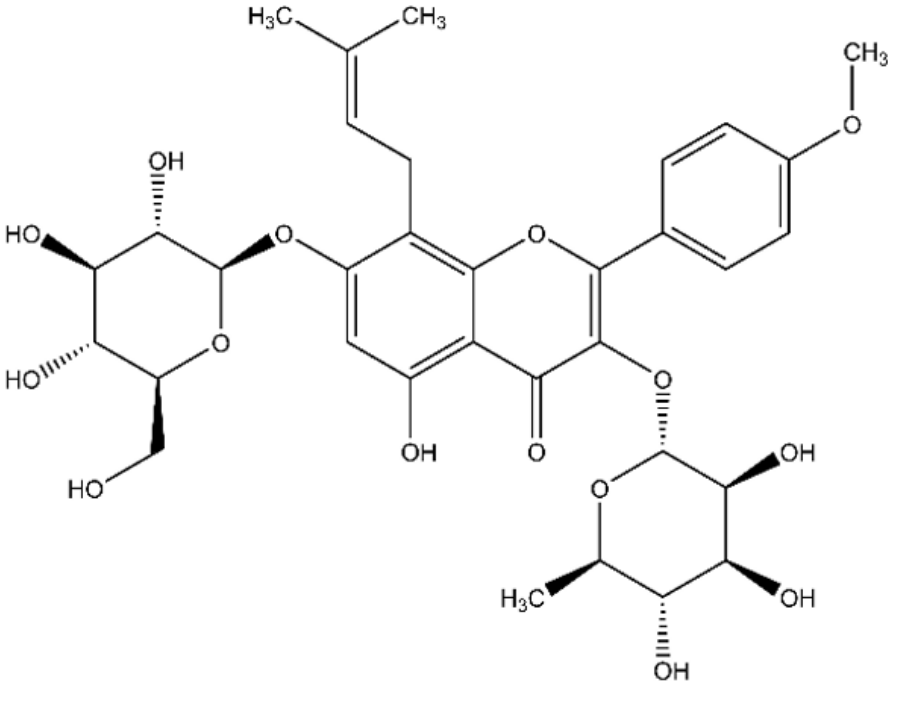
Figure 1. Chemical structure of icariin.